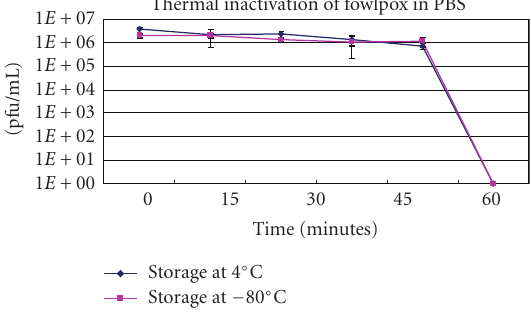
Figure 4: The inactivation of fowlpox virus stored at 4 ◦ C and − 80 ◦ C for one week and inactivated at 56 ◦ C in PBS, pH